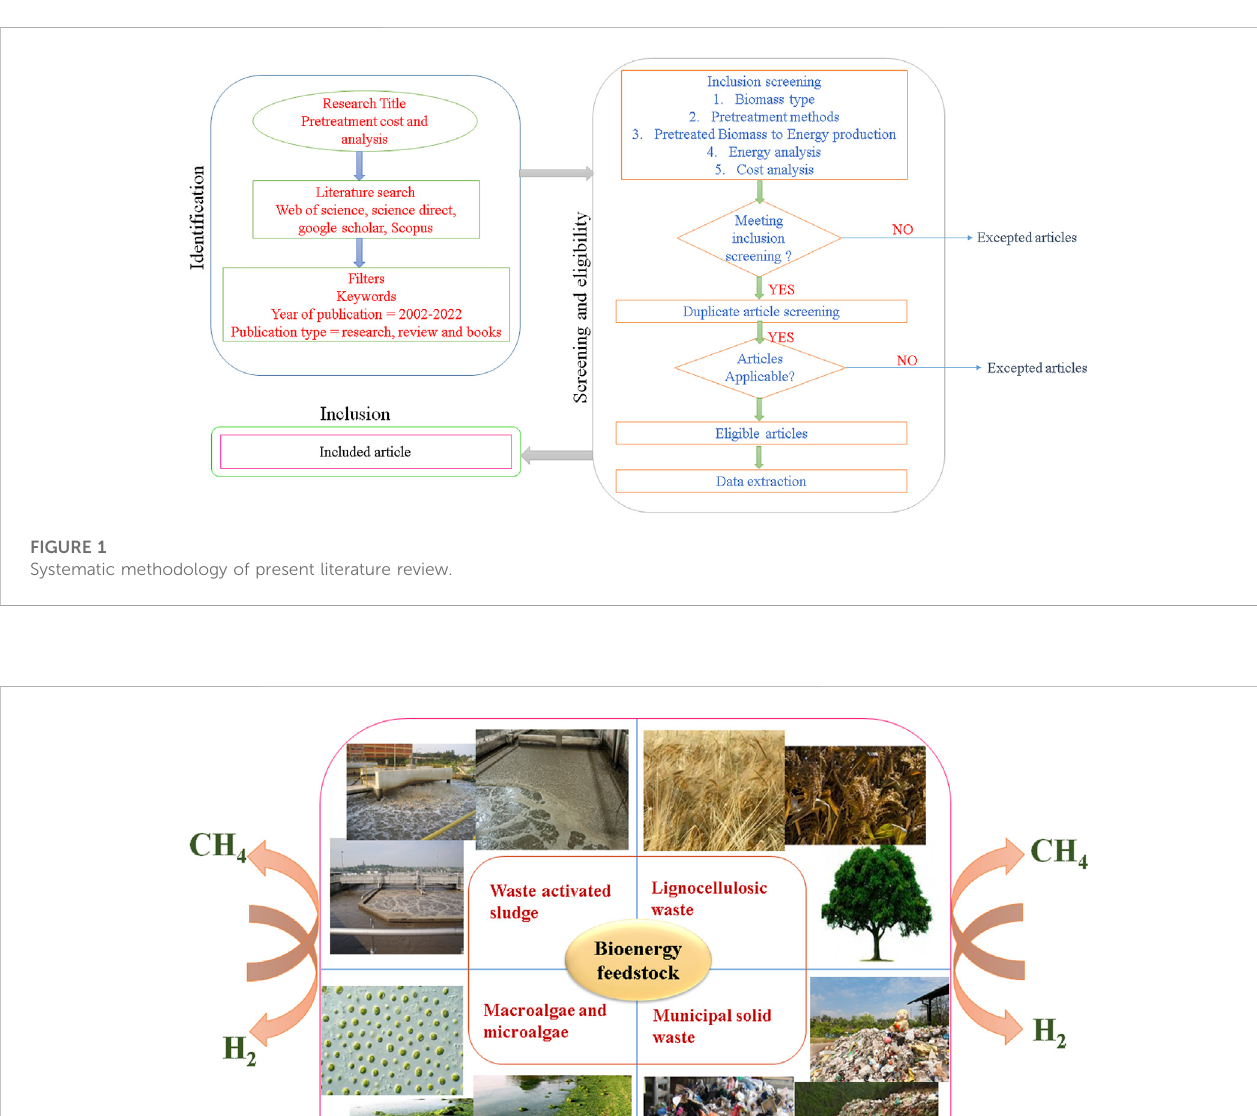
(cid:129) What are the different future perspectives that emerge from these papers?